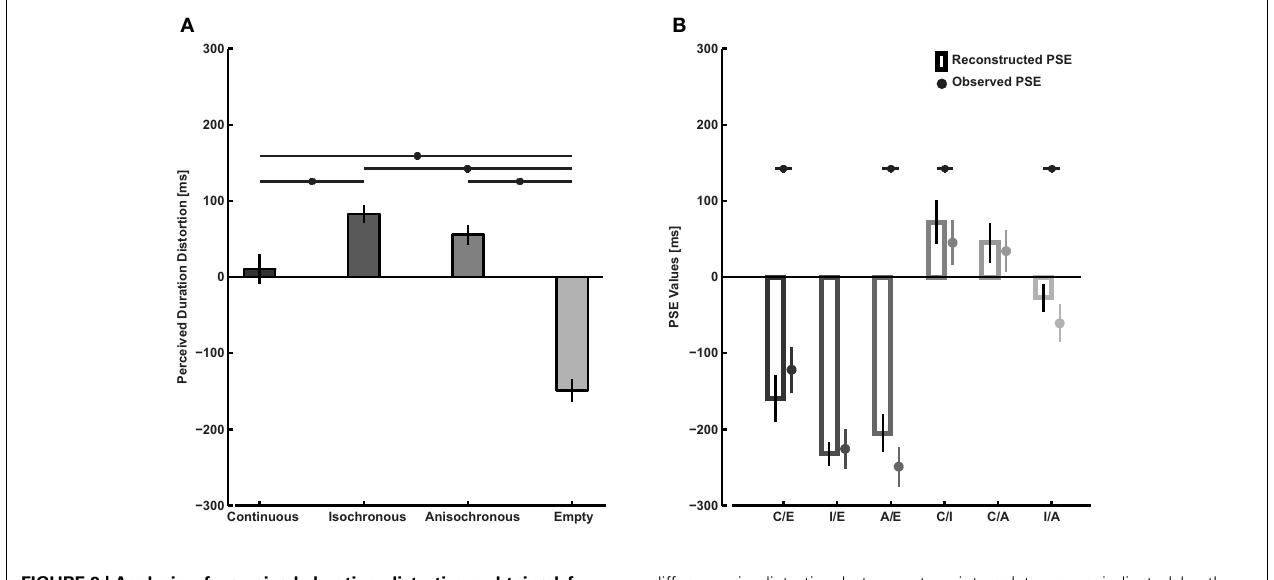
difference in distortion between two interval types as indicated by the horizontal lines. (B) Empirical PSE values compared to reconstructed PSE values from the calculated perceived duration distortions. Asterisks indicate a significant difference between the two, suggesting that factors other than duration distortion of the two intervals to be compared might have affected participant’s